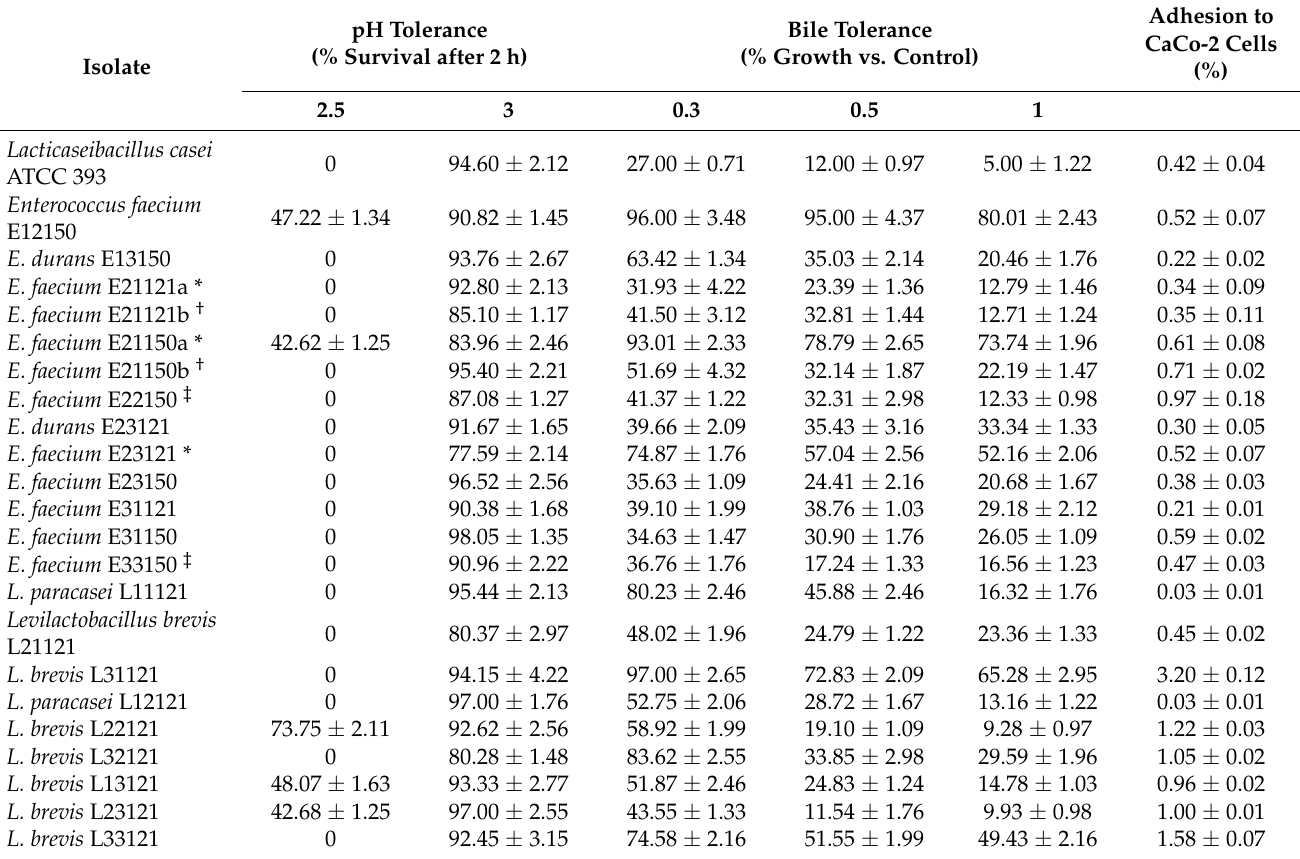
Table 2. LAB tolerance to pH 2.5 and 3.0, to bile salts 0.3, 0.5 and 1% ( w / v ) and adhesion capacity to CaCo-2 cells. Isolate labels “L” or “E” stand for lactobacilli and enterococci, respectively; the first following number indicates the dairy, the second the lot and the three last numbers indicate the day of isolation (121 or 150). Letters at the end distinguish isolates obtained from the same